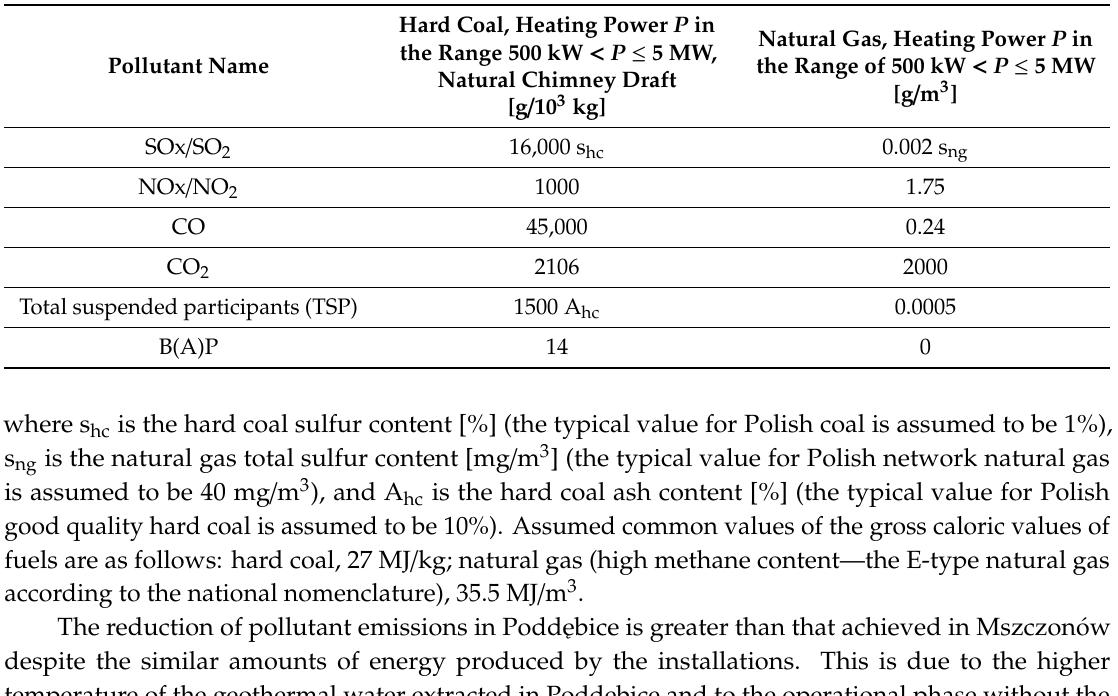
Table 1. Emission factors for selected fuels and types of energy sources